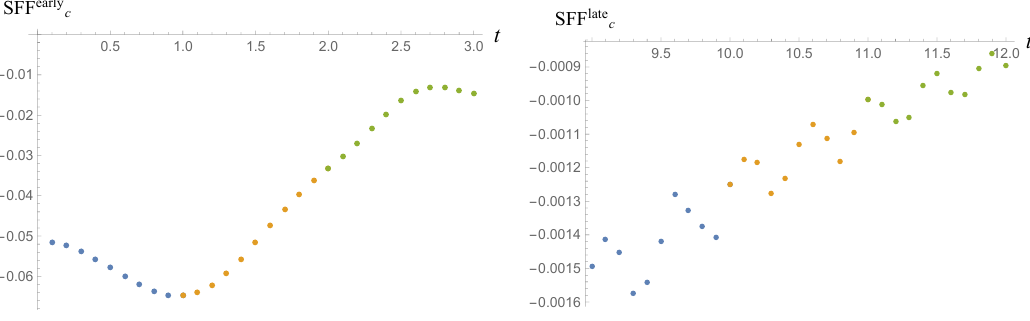
Figure 8 . Left: the early time behaviour of the exact connected SFF for (cid:22) = 1 ; (cid:12) = 1. Right: the late time behaviour for which the (cid:13)uctuations become O ( j SFF c j